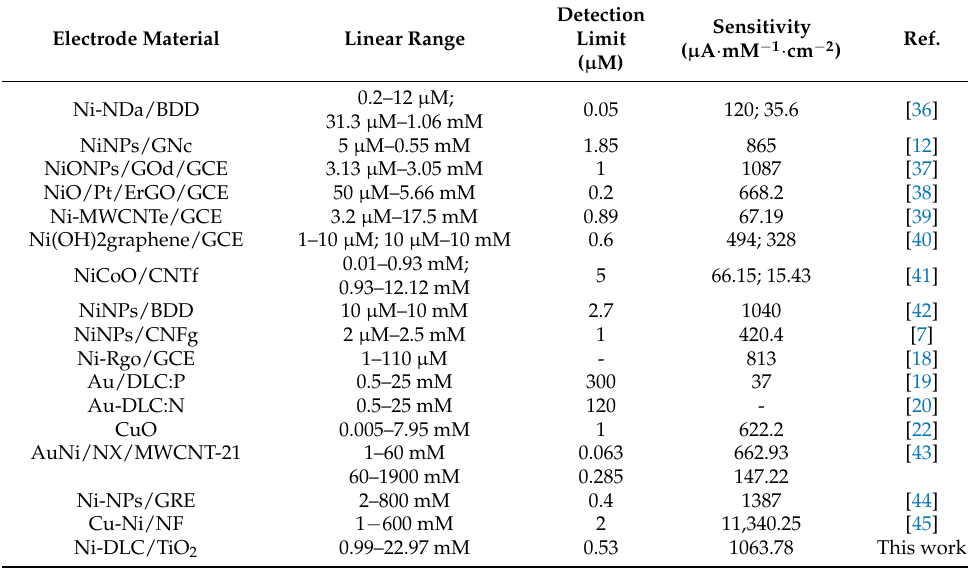
Table 1. Comparison of the performance of the proposed sensor and those of similar ones described in the